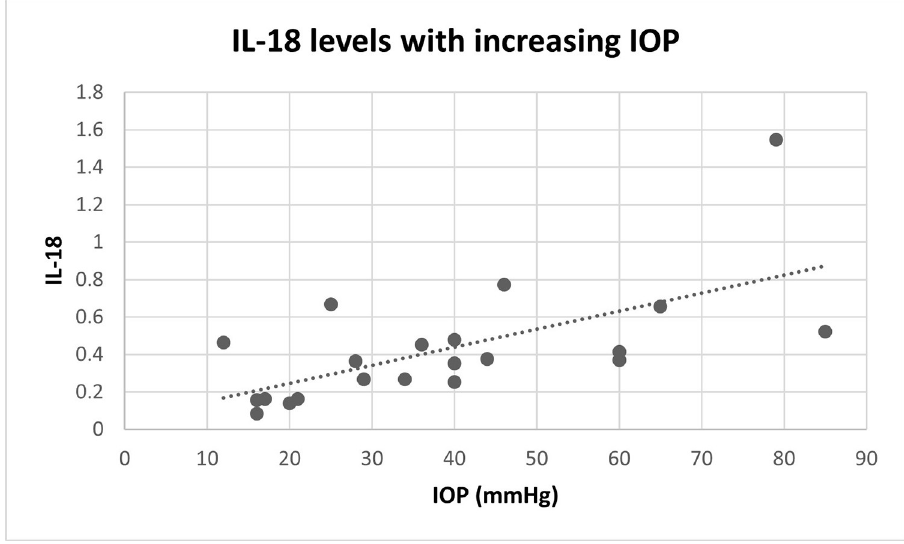
Fig 2. IL-18 and intraocular pressure. IL-18 levels (normalized Total Peak Area, nTPA) in the aqueous humor of canines were positively correlated with intraocular pressure (Spearman correlation = .64, p = .03).